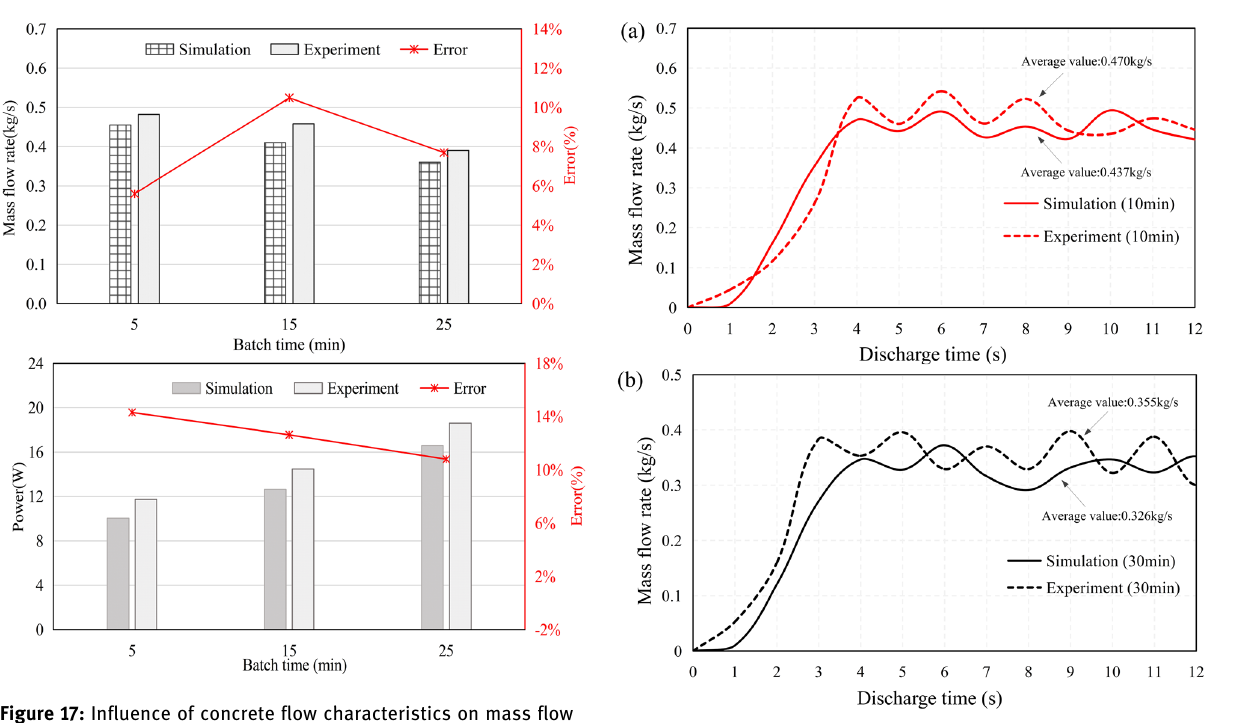
Figure 18: In fl uence of concrete fl ow characteristics on mass fl ow rate at di ff erent batch times: ( a ) 10 min and ( b ) 30 min.